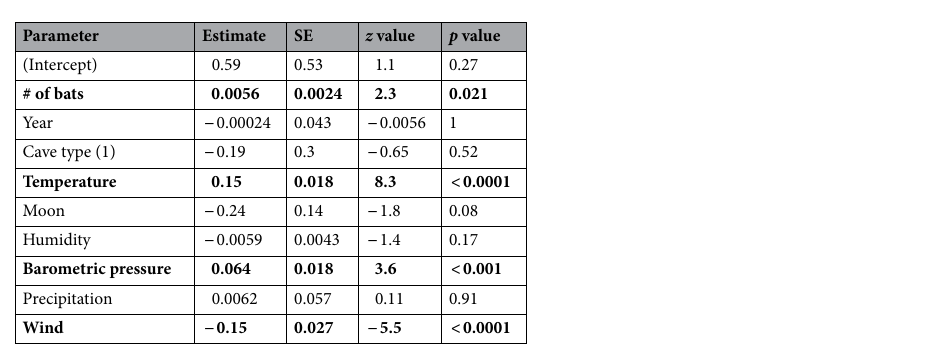
Table 2. β coefficients (in log e units) for variables affecting cave-exiting activity in 9 caves during winter for Townsend’s big-eared bats from 2011 to 2018 in southeastern Idaho, USA. Significant parameters are bolded.